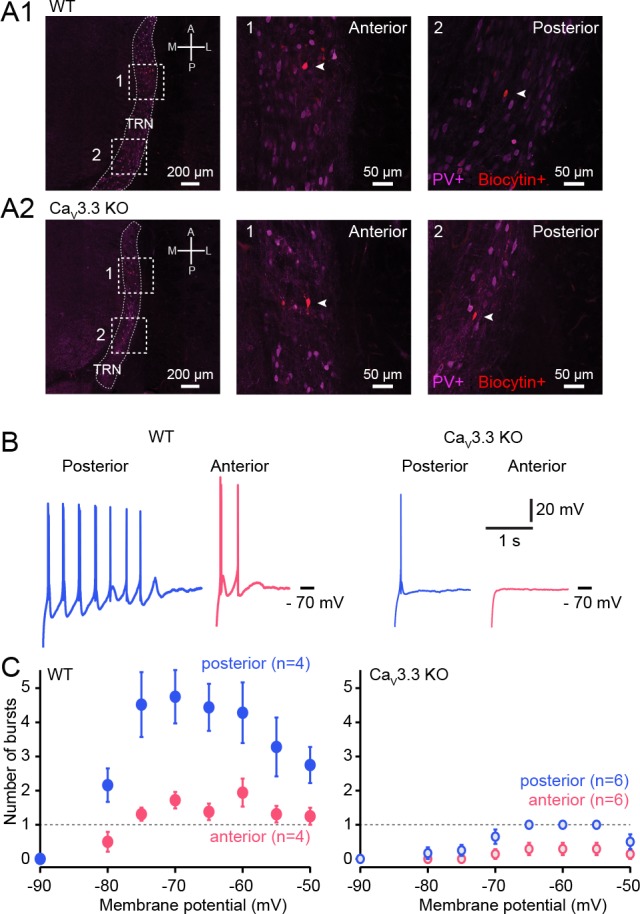
Oscillatory burst firing varies across the anteroposterior extent of TRN and depends on CaV3.3 Ca2+ channels.(A) Epifluorescent micrograph of horizontal brain sections (A1, WT; A2), CaV3.3 KO mouse) showing the TRN’s anteroposterior extent (magenta, PV-staining, PV+) and two biocytin-filled neurons (red, biocytin+) recorded through in vitro whole-cell patch-clamp in anterior and posterior locations. Squares defined by dashed-lines on the left micrograph (5x) are shown expanded on the right (10x). (B) Left: Representative traces of oscillatory burst firing of TRN neurons in response to hyperpolarizing current injections (left, WT; right CaV3.3 KO) in the posterior/sensory sector of the TRN (blue) and in the anterior/limbic sector (red). (C) Inverted U-shaped voltage-dependence of burst firing for posterior (WT, n = 4; CaV3.3 KO, n = 6) and anterior (WT, n = 4; CaV3.3 KO, n = 6) cells. Neurons in the posterior location of WT cells showed more repetitive burst discharge between −65 and −60 mV than anterior neurons (posterior: 4.4 ± 0.8, anterior: 1.7 ± 0.3, Mann-Whitney test, p=0.042). CaV3.3 KO mice showed an abolition of repetitive bursting in both locations in comparison to WT (posterior: 1.0 ± 0.0, anterior: 0.3 ± 0.2, Mann-Whitney tests, p=5.7×10−4 for posterior, p=0.019 for anterior).